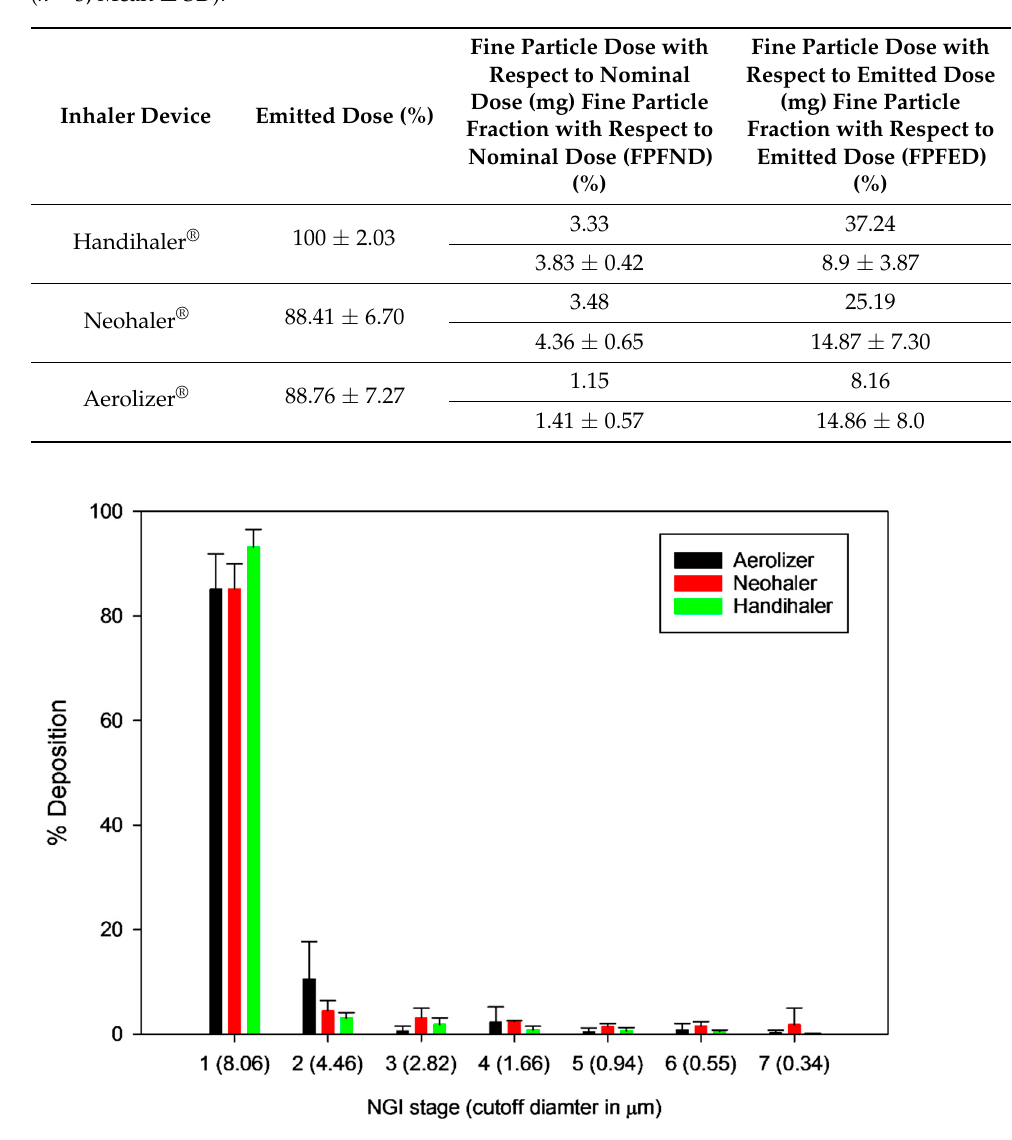
( b ) Figure 8. In Vitro Vell Viability of: ( a ). A549 and ( b ). H358 human pulmonary cell lines. * p value < 0.001, ** p value 0.010, *** p value 0.015. ( n = 6, Mean ± SD).